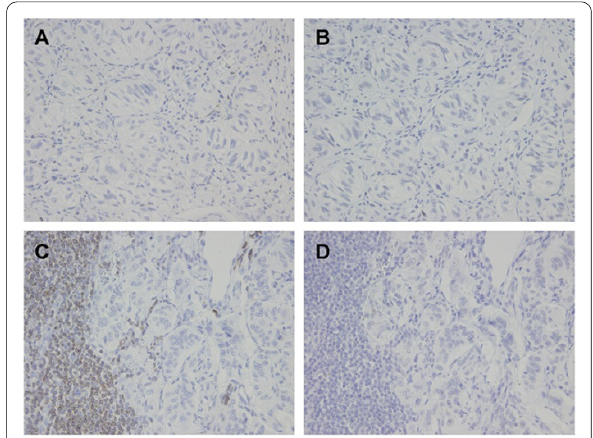
Figure 4 Photomicrographs showing immunohistochemistry for bcl-2 and p53 . (A and B) Tumor cells in primary focus showed negative reactivity for both bcl-2 and p53 (× 400). (C and D) Tumor cells in met- astatic focus showed negative reactivity for both bcl-2 and p53 (×